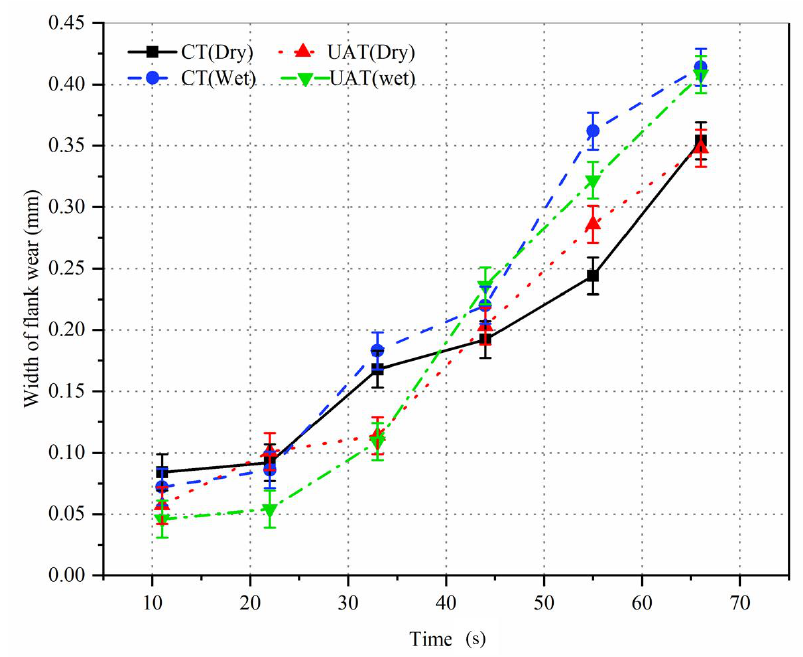
Figure 4. Variation in flank wear with machining time in CT and UAT under dry and wet conditions ( 𝑉 = 50 m/min, 𝑓 = 0.2 mm/rev, 𝑎 = 0.4 mm).